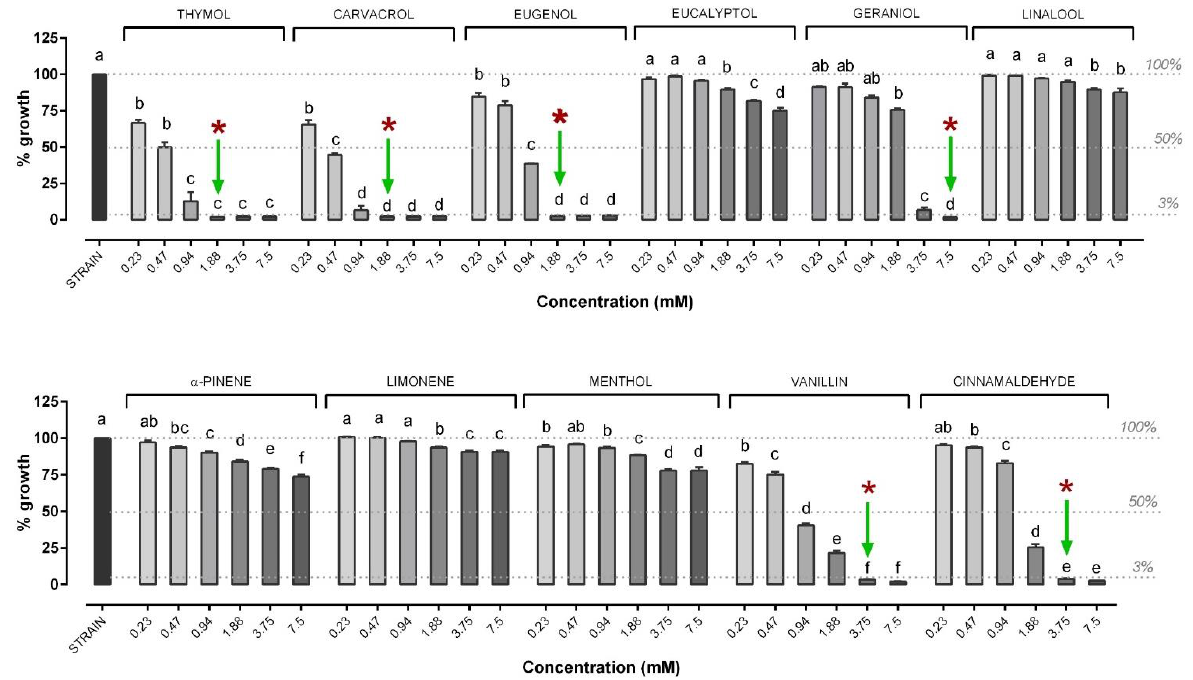
Figure 4. Growth of V. anguillarum strain after 24 h of incubation with the different nature-identical compounds (NIC). V. anguillarum growth is expressed as a percentage relative to control (strain), and values are presented as the mean ± SEM ( n = 3). Data within each NIC were analyzed with one-way ANOVA (including the strain value) and columns with different letters were significantly different ( p ≤ 0.05). Concentrations of each compound are reported in the X axis, while the percentage of growth in the Y axis is reported compared to control. The dashed lines indicate (from top to bottom): control strain level (set as 100% of growth), 50% of growth compared to control (possible NIC concentrations able to inhibit 50% bacteria) and the level below which the doses of NIC were considered to inhibit bacterial growth (3%). Green arrows indicate MIC while red asterisks indicate the MBC value. When not present, MBC was higher than ≥7.5 mM. The MBC was defined only for those compounds that showed an MIC value among the tested concentrations.